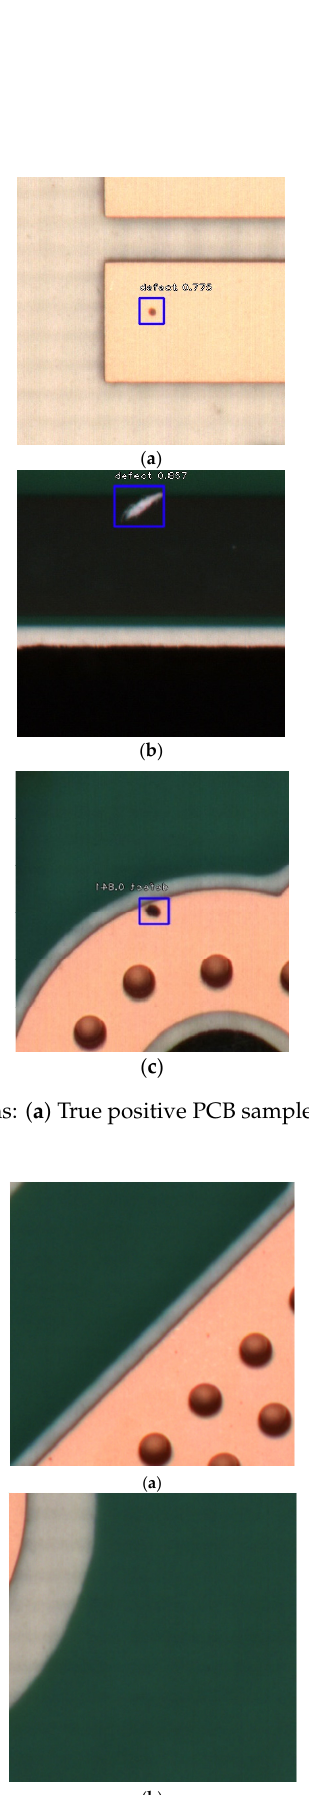
Figure 7. False positive PCB sections: ( a ) False positive PCB sample 1. ( b ) False positive PCB sample 2.